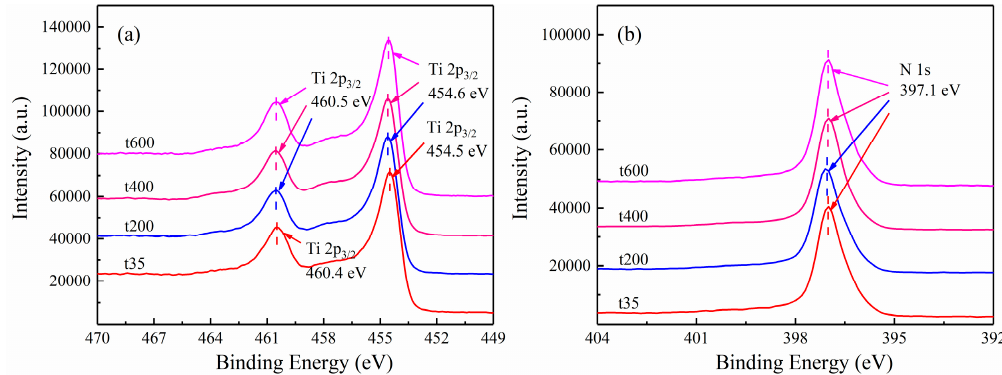
ff erent substrate temperatures: ( a ) Ti 2p; ( b ) N Figure 5. Binding energy of TiN coatings under different substrate temperatures: ( a ) Ti 2p; ( b ) N 1s. Figure 5. Binding energy of TiN coatings under di